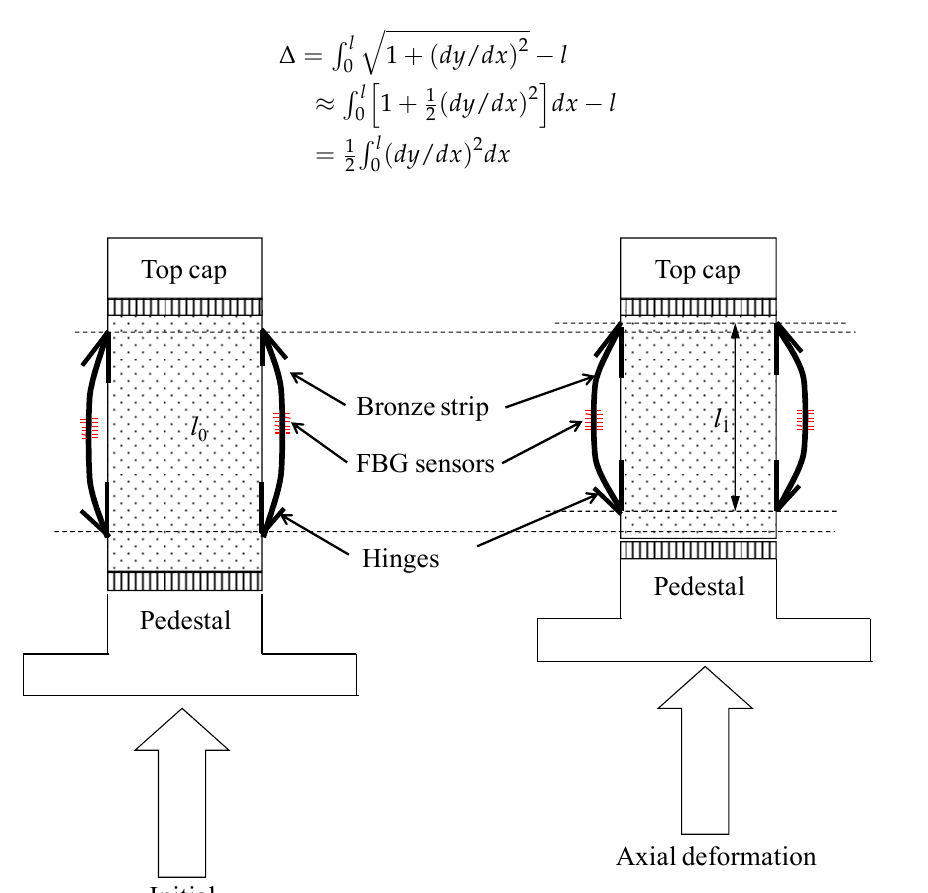
Figure 3. Schematic illustration of working principle of the SDT.